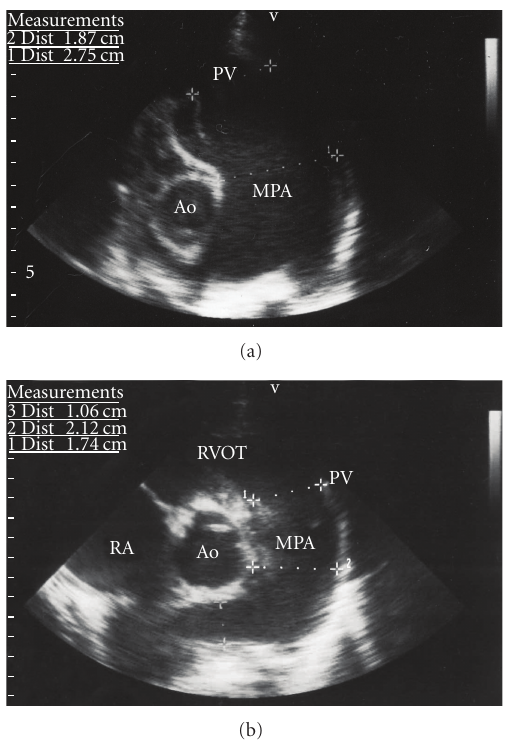
Figure 1: Parasternal short-axis view of the pulmonary valve (PV) and main pulmonary artery (MPA) of the patient preoperatively (a) and directly postoperatively (b). The severe dilatation of the PV (diameter 22mm) and MPA (diameter 27mm) diminished directly postoperatively, almost to normal limits (17.4 mm and 21.2mm, resp.). RA: right atrium; RVOT: right ventricle outflow tract; Ao: aorta.